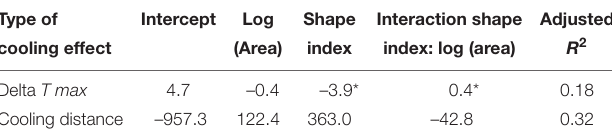
TABLE 4 | Linear regression model results as basis for the quantification of cooling